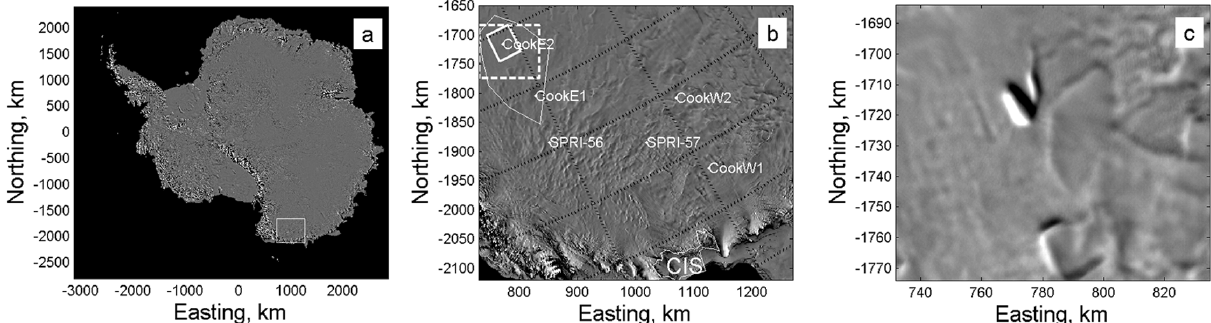
Fig. 1. Situation map of the area of interest. (a) MODIS Mosaic of Antarctica (Scambos et al., 2007); the white box delineates panel (b) ; (b) : zoom on the area of interest, the Cook Ice Shelf (labelled CIS) is outlined in white. Known subglacial lakes (Wright and Siegert, 2012) are located by white dots and labelled. The dashed white box delineates the area shown in panel (c) and Fig. 10, the tilted white box is the area shown in Fig. 4, and the thinner white contour delineates the area for which the SPOT5 DEM is available; (c) : MODIS Mosaic Of Antarctica 2009 (T. Scambos, personal communication, 2013), showing the trough left by the lake drainage illuminated by low sun from the upper right